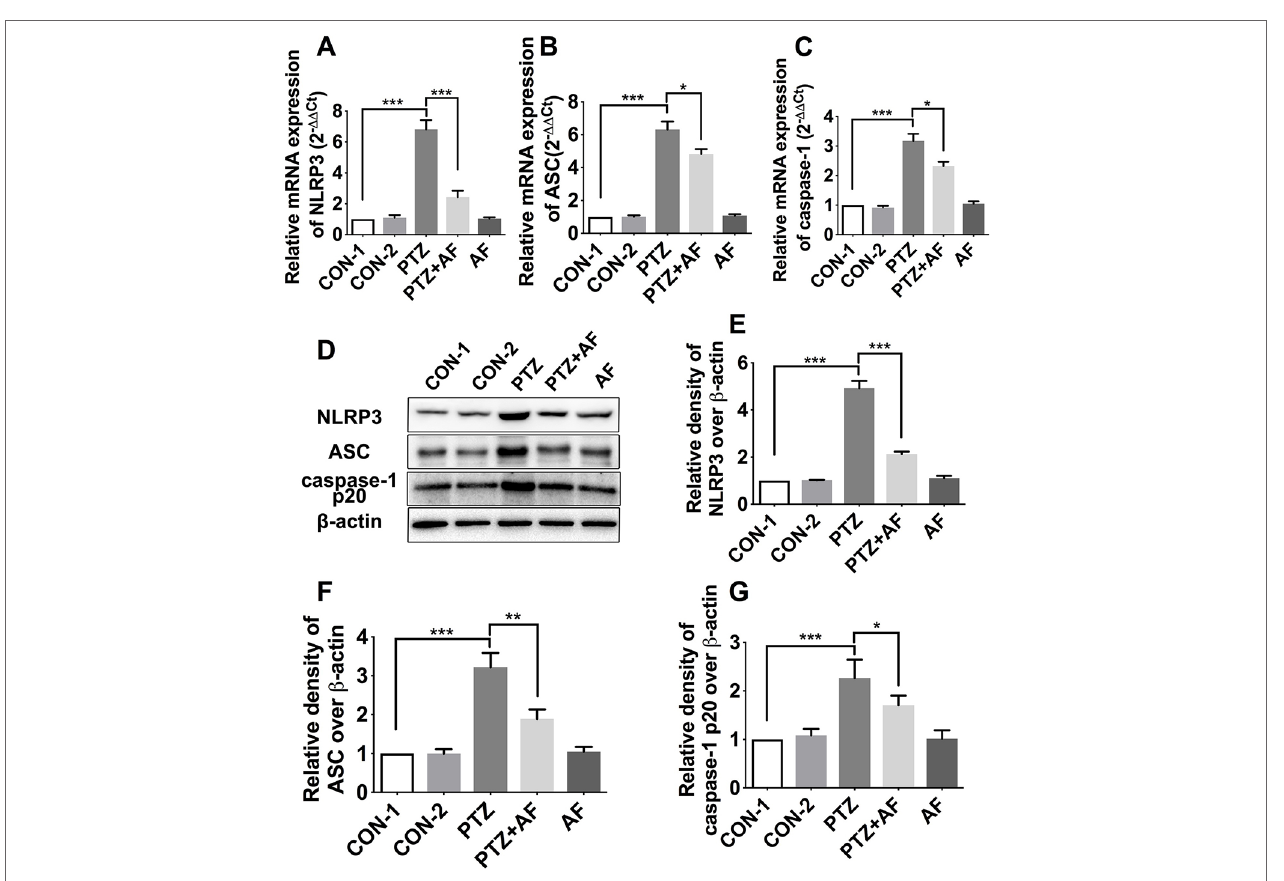
FIGURE 4 | Effects of amentoflavone on the expression of hippocampal NLRP3 inflammasome in PTZ-induced kindling mice. (A – C) mRNA expression level of NLRP3 inflammasome (NLRP3, ASC, and caspase-1) in different groups ( n = 6 mice per group, Student’s t test ). (D) Representative immunoblots of NLRP3, ASC, and caspase-1 p20 proteins in different groups. (E – G) Semi-quantitative analysis of the relative levels of NLRP3, ASC, and caspase-1 p20 by densitometric analysis ( n = 6 mice per group, Student’s t test ). Error bars represent mean ± s.d. *, **, *** represent p < 0.05, p < 0.01, p < 0.001, respectively. PTZ, pentylenetetrazole; AF,